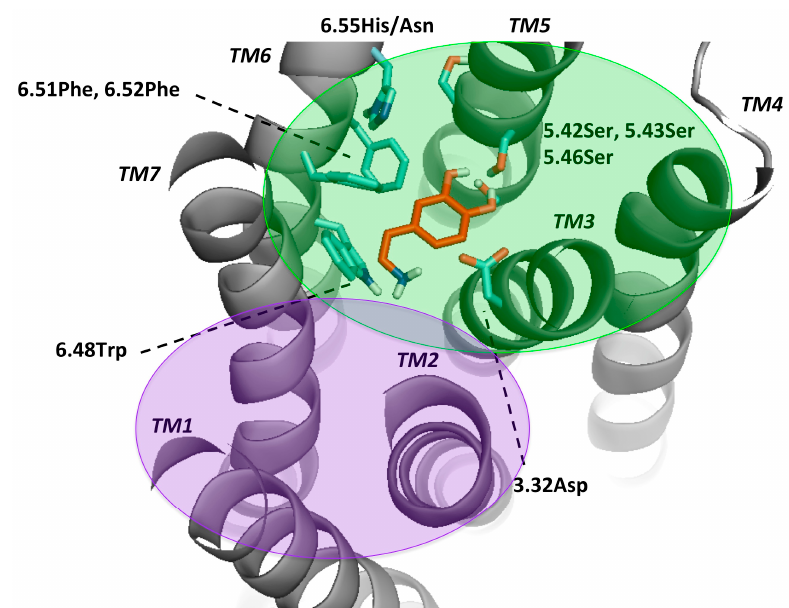
Figure 2. Key residues for molecular docking of Dopamine to DR models. Residues were designated in bold and colored in cyan, TMs in bold and italic. This set-up was kept for Figures S3–S7 and highly corresponds to the definition of the binding pocket of Floresca and Schnetz [47]. The area of the orthosteric and secondary binding pockets were colored and violet, respectively.